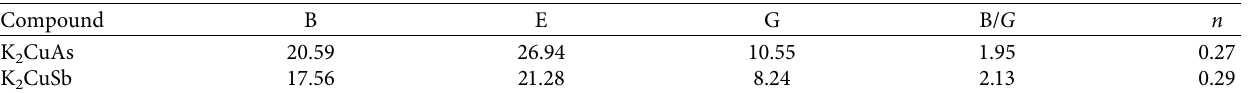
Table 4: Voigt ̶ Reuss–Hill approximations of bulk modulus B (GPa), Young’s modulus E (GPa), shear modulus G (GPa), Pugh’s ratio B/ G , and Poisson’s ratio n